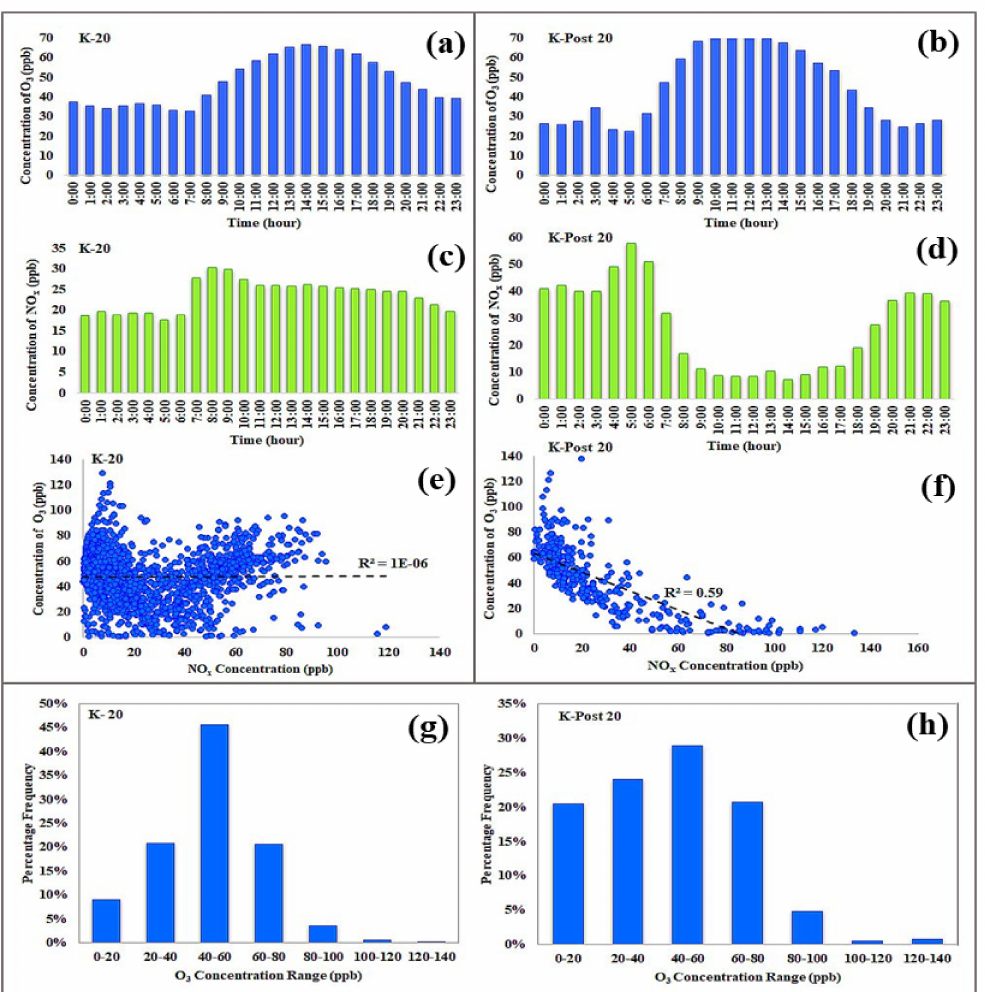
Figure 5. Diurnal distribution of average hourly O 3 ( a , b ) and NO x concentrations ( c , d ), linear correlations between O 3 and NO x ( e , f ), and frequency distribution of hourly O 3 ( g , h ) during (K-20) and after the lockdown period (K-Post 20) at the work site (K